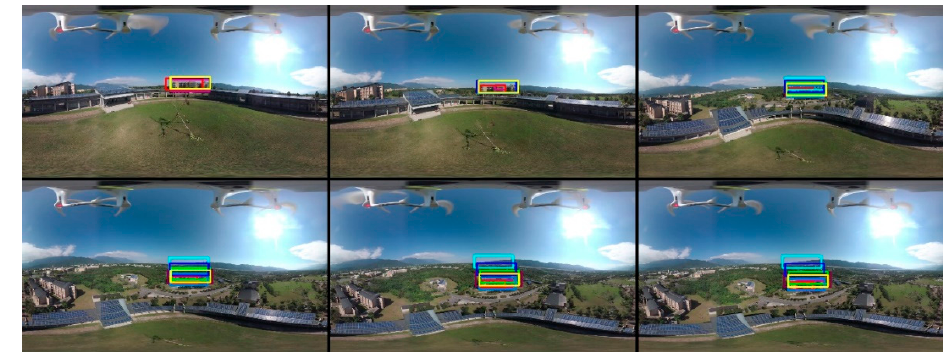
Figure 11. Tracking results on 360-degree video sequence 8 (tracking windows with different colors: MOSSE MIL MedianFlow BOOST TLD KCF GOTURN CSRT).